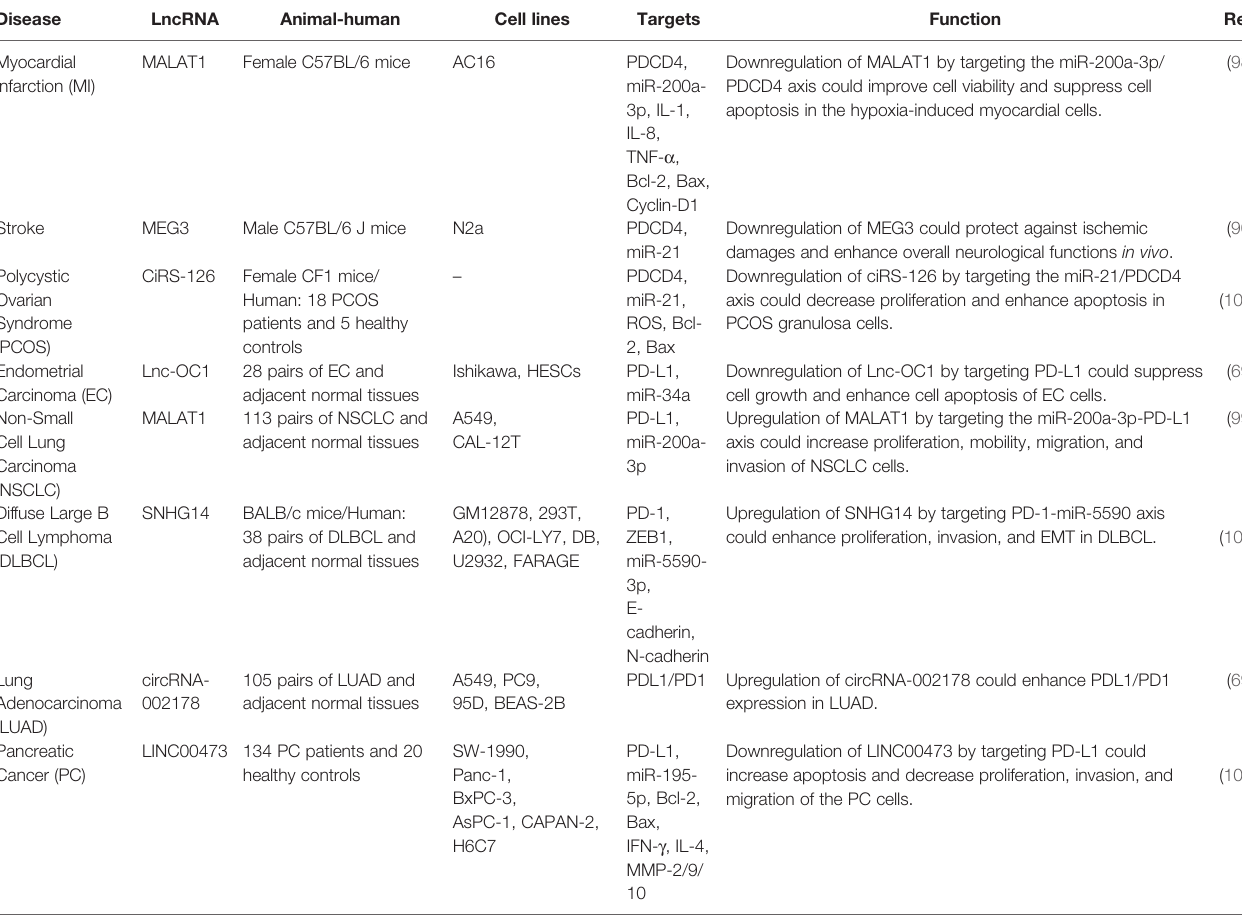
TABLE 11 | Interaction between lncRNAs and PDCD in different